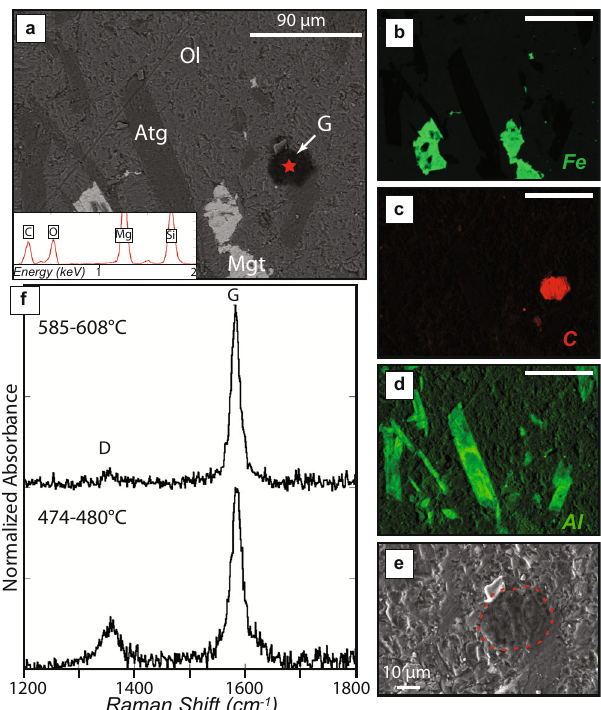
Fig. 4 Carbonaceous matter in inclusions in a metamorphic olivine crystal (sample ZE17-16). a – d Back-scattered SEM image with associated EDS element maps (Fe, C, and Al) of metamorphic olivine containing inclusions of antigorite, magnetite, and graphite-like (G) carbonaceous matter. The red star corresponds to the EDS analysis of the carbonaceous matter, shown in a box on Fig. 4a. e SEM in lens images of graphite-like (G) carbonaceous matter showing that it is within the olivine crystal. f Raman spectra of graphite-like carbonaceous